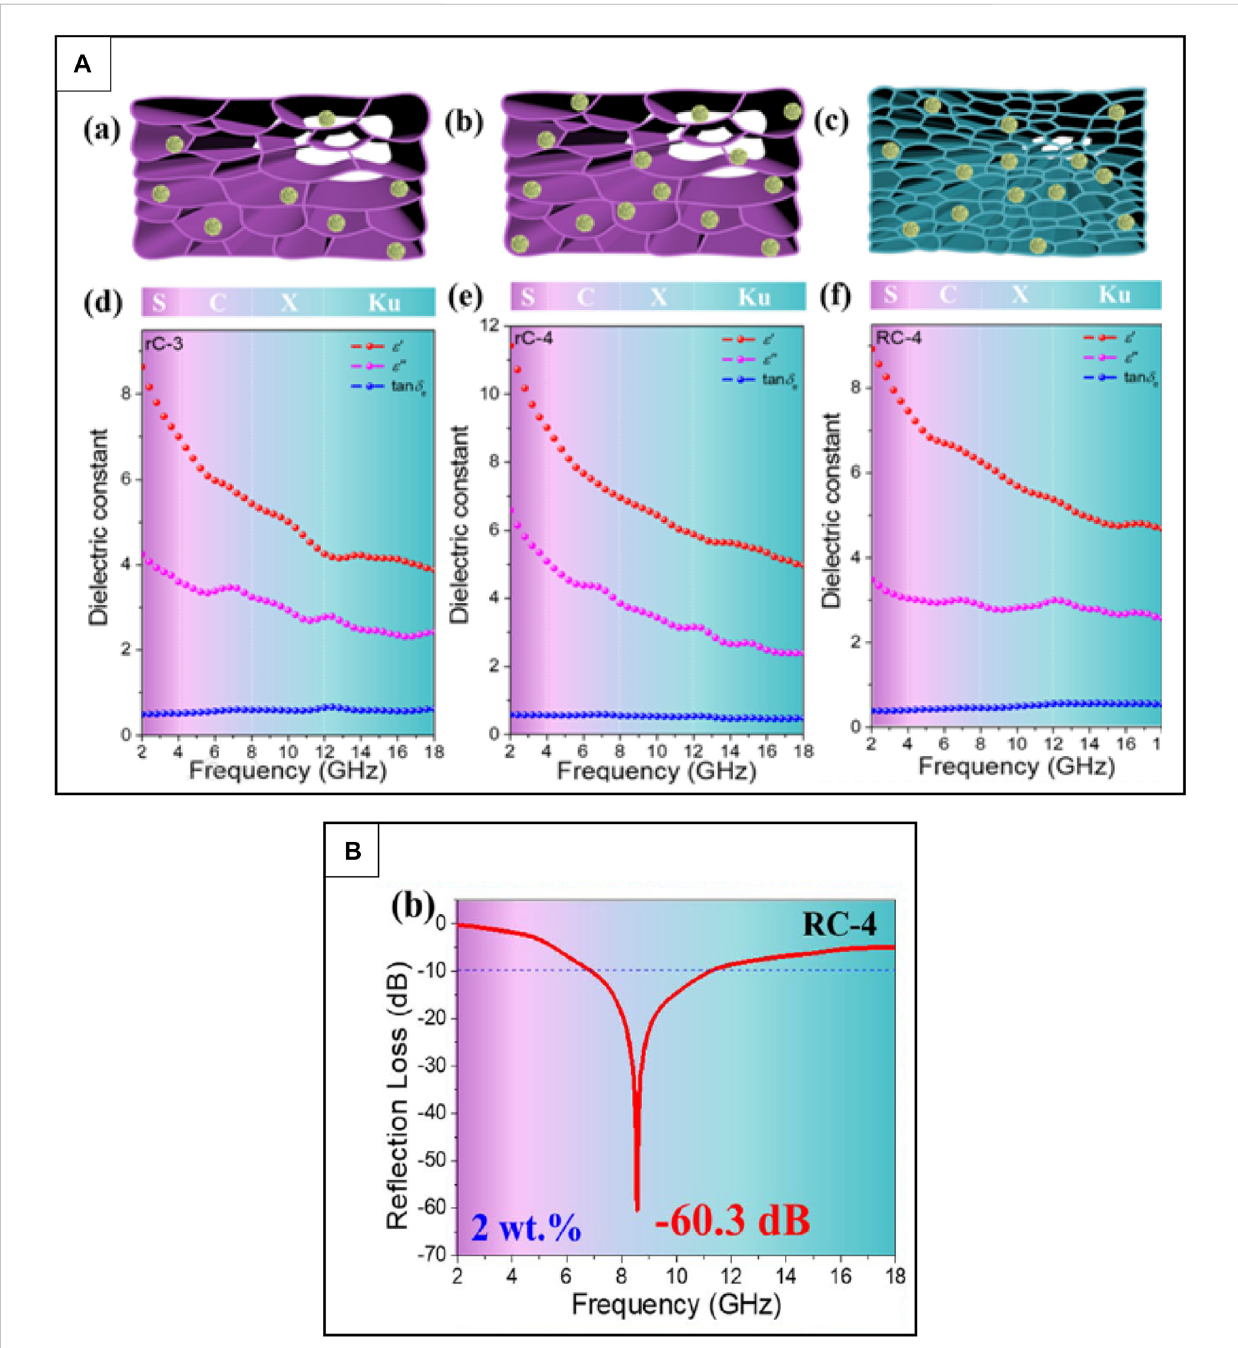
FIGURE 7 (Aa – c) Comparisonsofthemorphologiesofthearchitectedsamples. (Ad – f) DielectricconstantsofrC-3,rC-4,andRC-4. (B) RLresultsoftheRC-4 sample (Wu et al.,